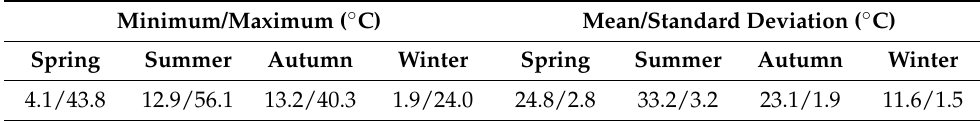
Figure 4. Mean spatial distribution of Wuhan’s land surface temperature (LST) for the four seasons of the year. Table 1. Descriptive statistics of the mean spatial distribution in Figure